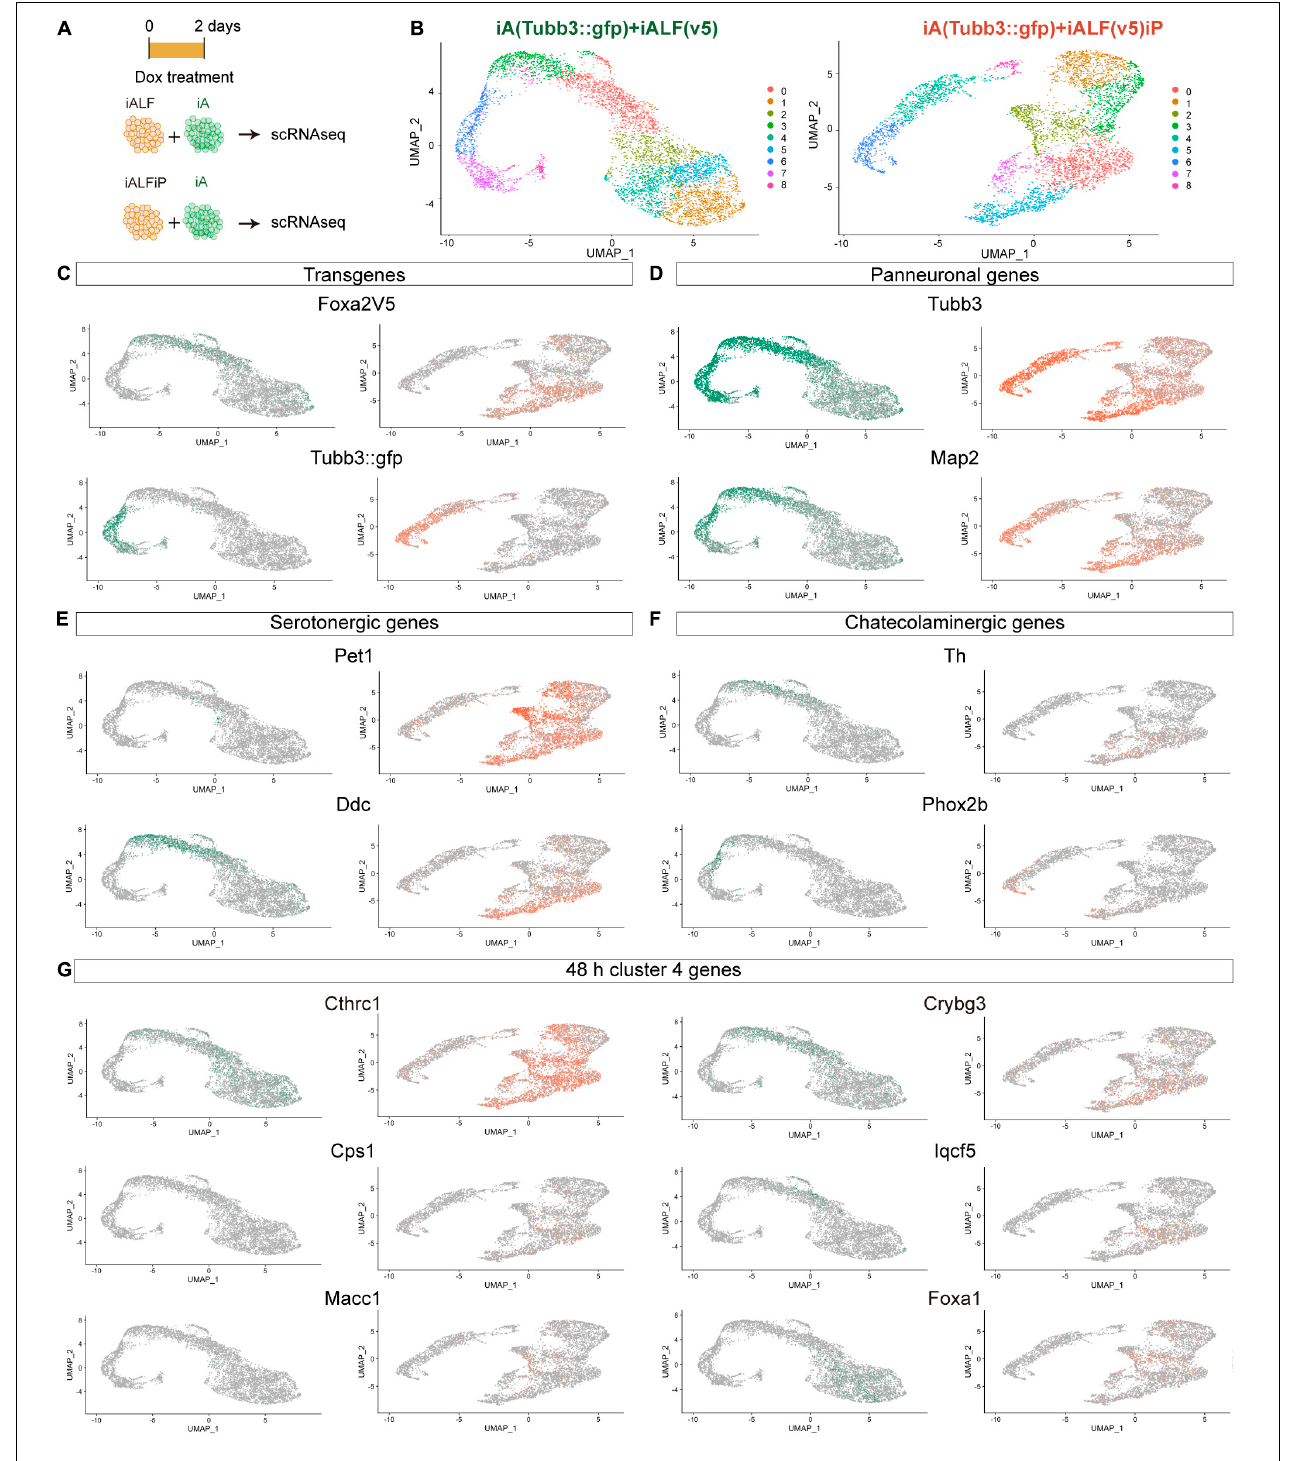
FIGURE 3 | Single-cell RNA-seq of iALF and iALFiP neurons at differentiation day 2. (A) Experimental outline. iALF and iALFiP cells were mixed with Tubb3:GFP-expressing iA cells for comparison. (B) UMAP visualization of iALF and iALFiP clustering. Clusters are shown in colors and numbered from 1 to 8. (C–G) Projection of specific genes in panel (B) . (C) Transgene expression clearly separates iA (Tubb3:GFP+) from iALF and iALFiP. (D) The transgene expression levels corelate with neural differentiation states suggesting a differentiation cline across cells. (E,F) Both lines contain cells expressing serotoninergic genes but iALFiP represses Phox2b. (G) Projection of representative Cluster 4 ( Figure 2D ) on the single cell clusters. (C–G) Green = expression in iALF + Tubb3:GFP, Orange = iALFP + Tubb3:GFP.